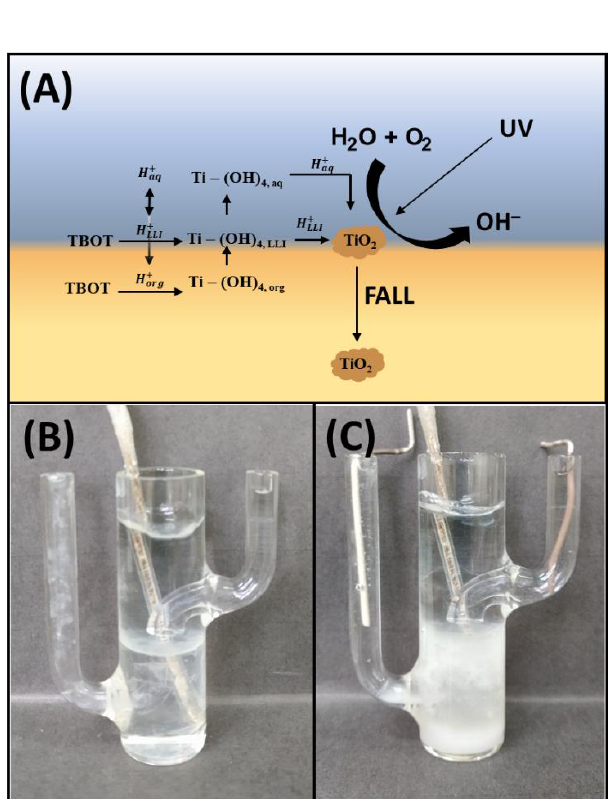
Figure 1. ( A ) Anticipated mechanisms laying behind the interfacial, electrochemically assisted TiO 2 polycondensation. The photo of the electrochemical cell was taken for 0.5% TBOT ( B ) before and ( C ) after LLI polarization.